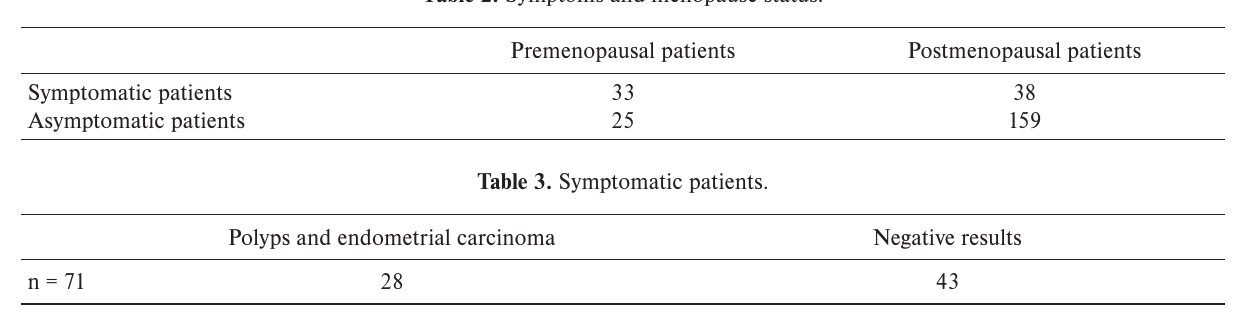
Table 4. Endometrial thickness.